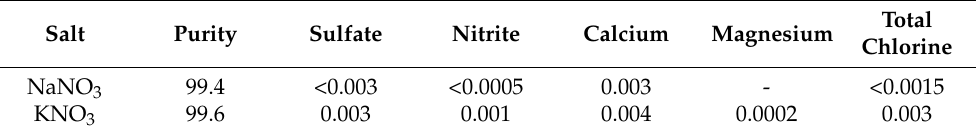
Table 3. Composition (in wt.%) of as-received nitrate salts used in this